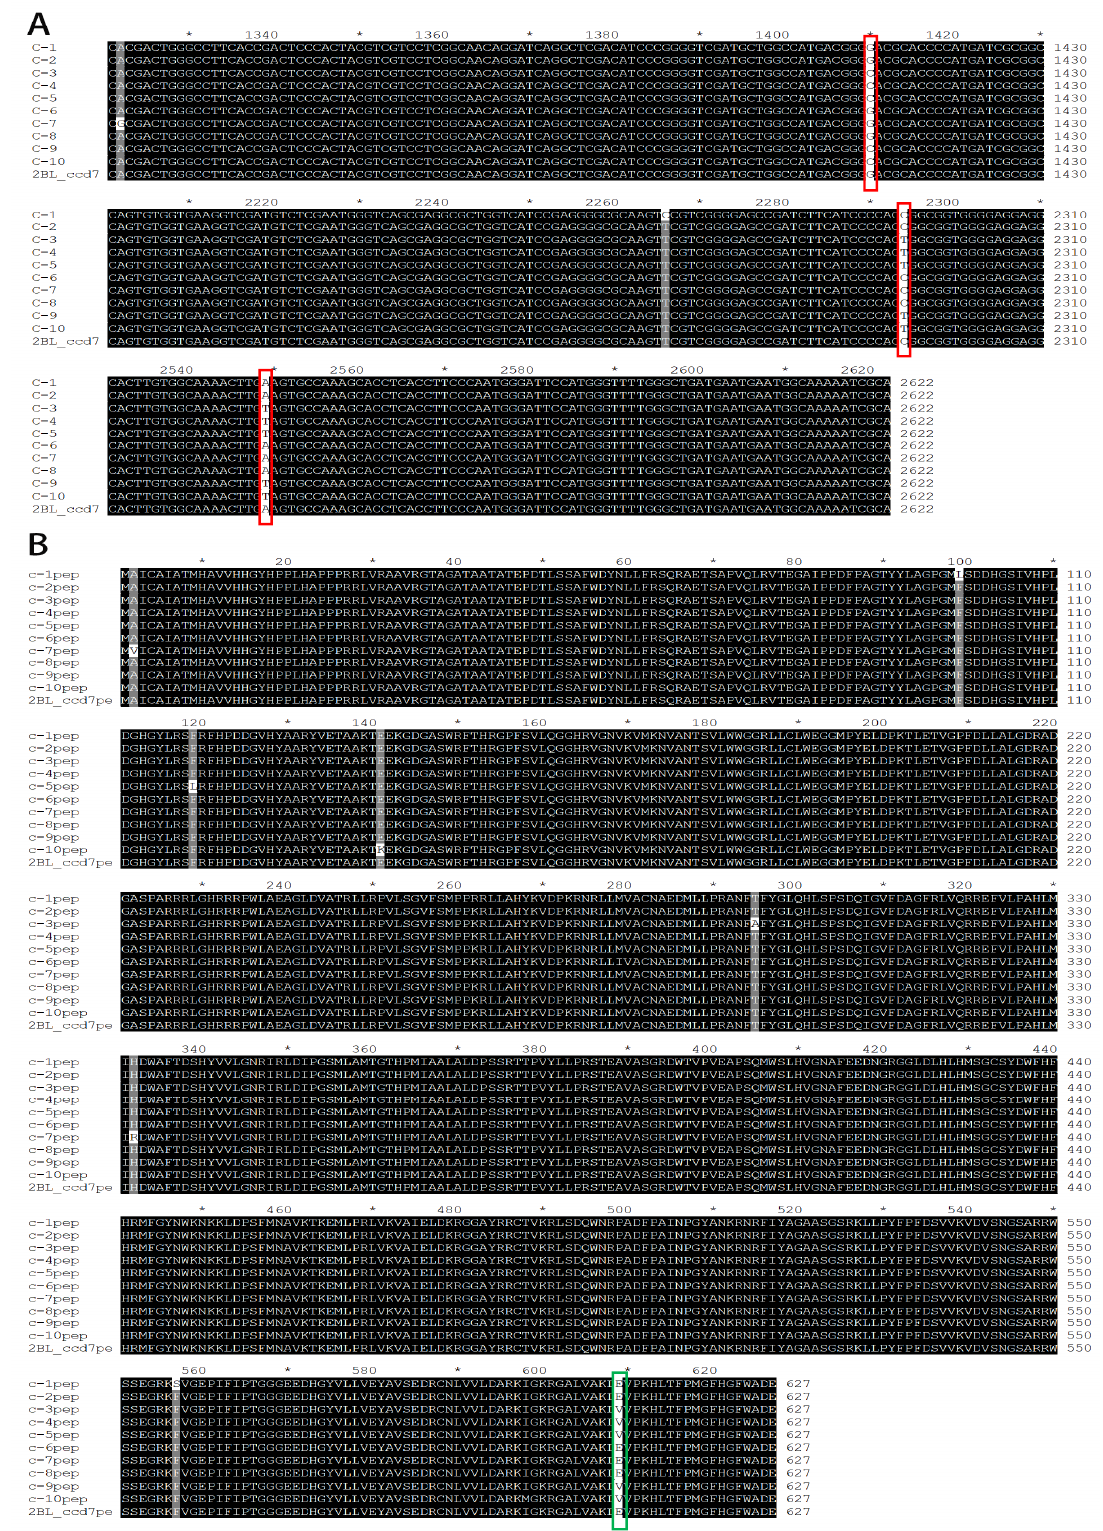
Figure 1. Multiple alignment of CCD7 genes ( A ) and proteins ( B ) in different wheat varieties. The alignment was generated in the Lasergene software package MegAlign Version 7. The red boxes indicate the three sites of point mutation within the cloned wheat sequences; the green box indicate the amino acid of the third mutation point in the cloned wheat sequences.